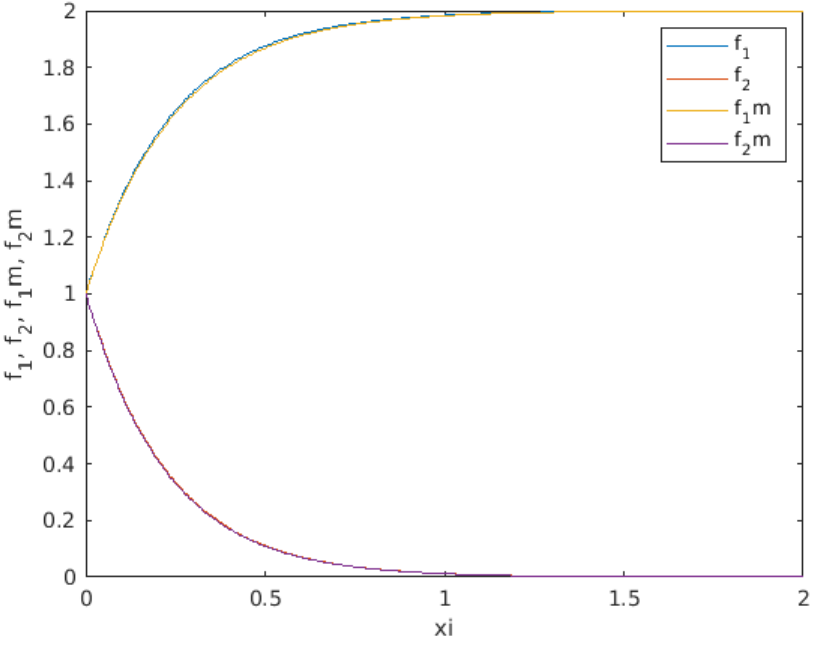
Figure 4. TW profiles for a + λ = 4 with n = 0.2, m = 0.9. For the sake of simplicity, r = 2. The numerical exercise was performed for an integration interval ( 0,100 ) ; nonetheless, the interval was cut for representation